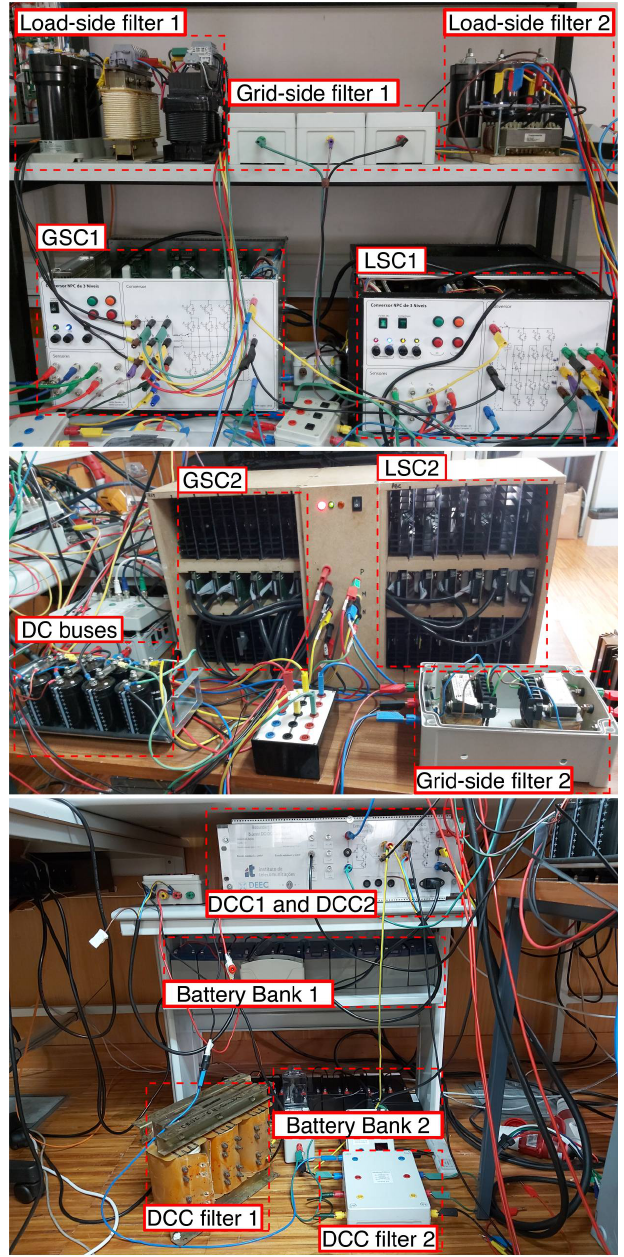
Figure 8. Experimental setup of the full